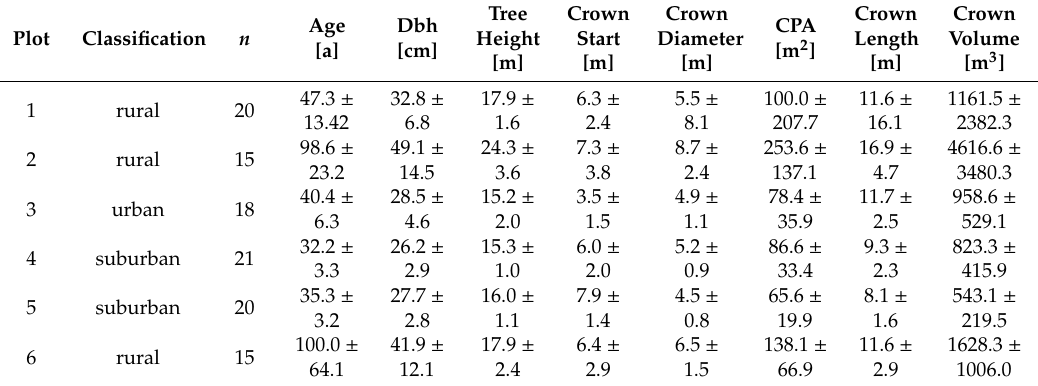
Table 3. Number of sampled trees per plot n with urbanity classification (urban, suburban, rural) and tree characteristics (age, dbh, tree height, crown start, crown diameter, crown projection area CPA, crown length and crown volume) of A. sachalinensis in Sapporo,